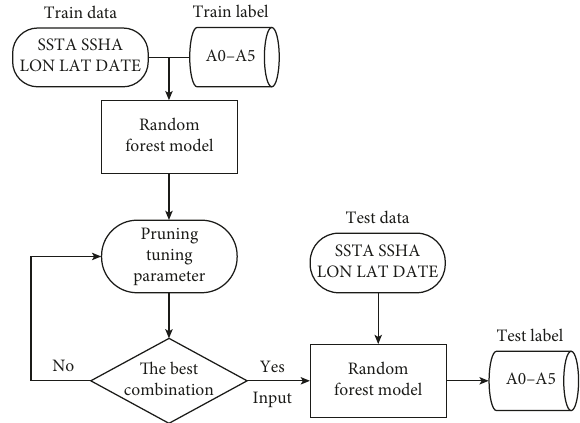
Figure 1: Training prediction flowchart of the random forest